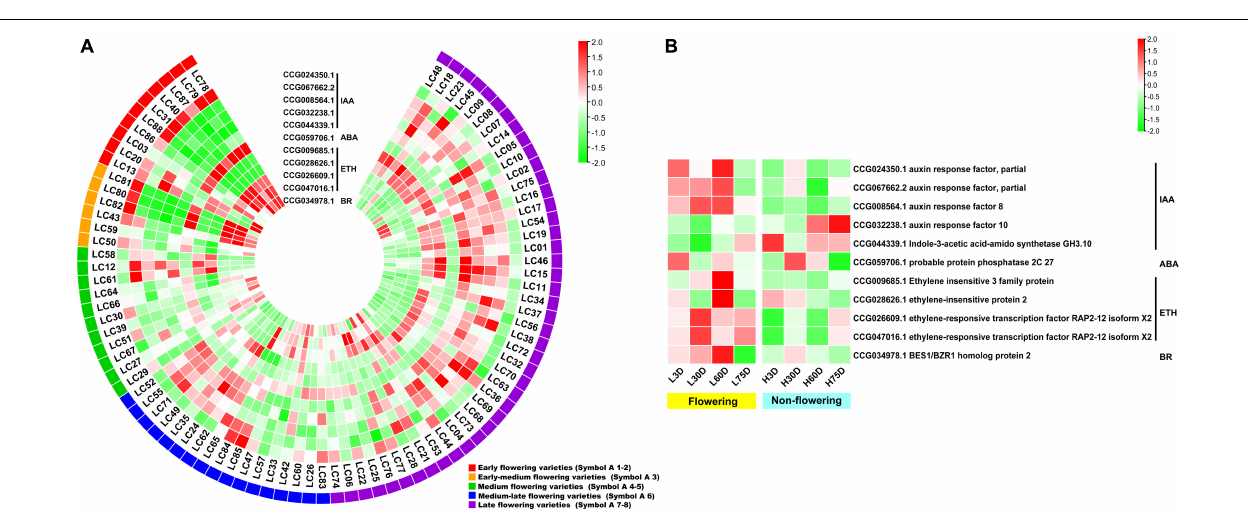
FIGURE 5 | Heat map diagram of the expression of the hormone signal induction-related CAGs. (A) Heat map of the expression levels of the hormone signal induction-related CAGs in the 87 litchi accessions. (B) Heat map diagram of the expression levels of flowering-related CAGs under low and high temperature conditions. L3D, L30D, L60D, and L75D indicate 3, 30, 60, and 75 days of the low-temperature treatment, respectively. H3D, H30D, H60D, and H75D indicate 3, 30, 60, and 75 days of the high-temperature treatment, respectively. FPKM values were normalized to Z